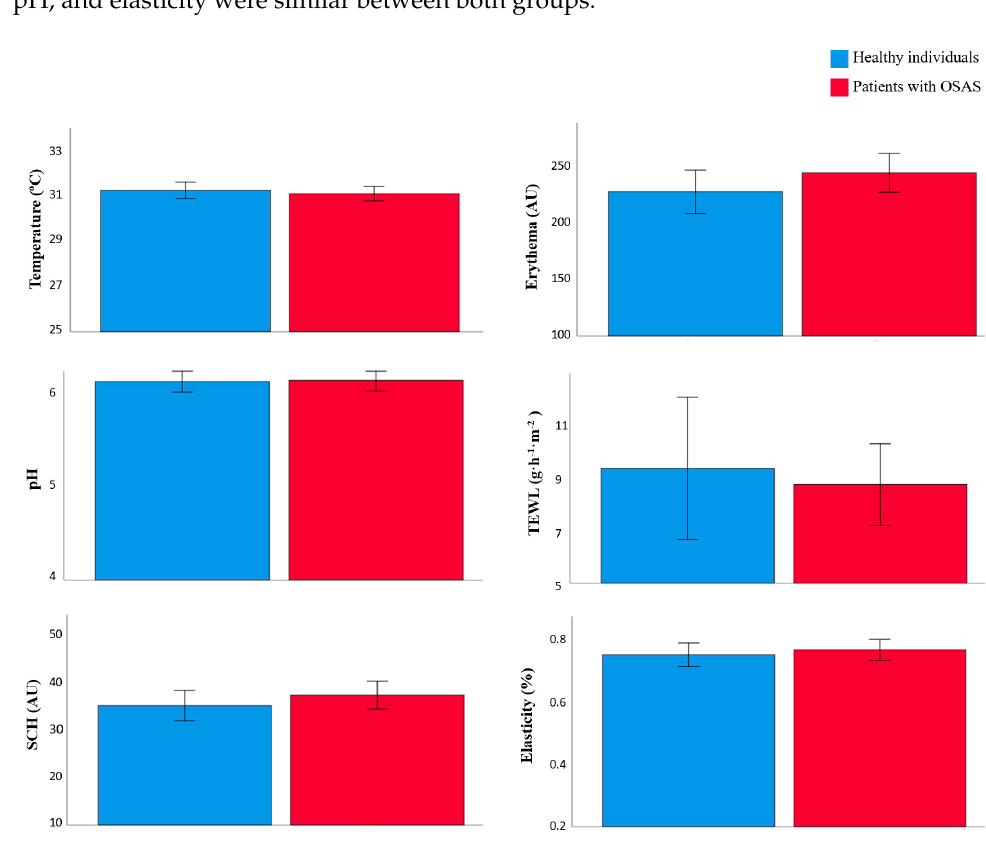
Figure 1. Skin barrier function parameters in healthy individuals and patients with OSAS.